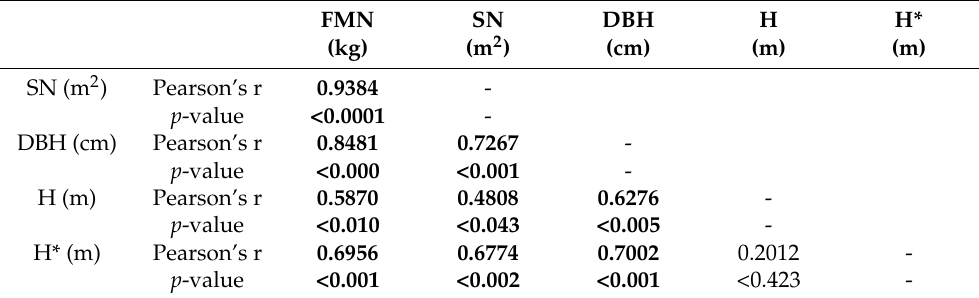
Table 1. Pearson’s correlation matrix between needle weight results and needle area and biometric features of 18 sample trees. Significant results ( p < 0.05) in bold.